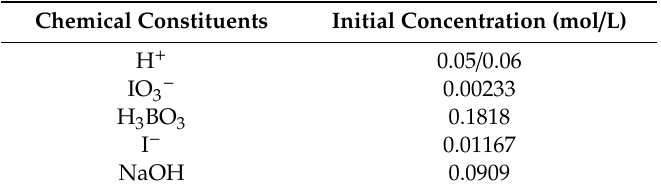
Table 4. Initial concentration of the chemical constituents in the experiment. Chemical Constituents